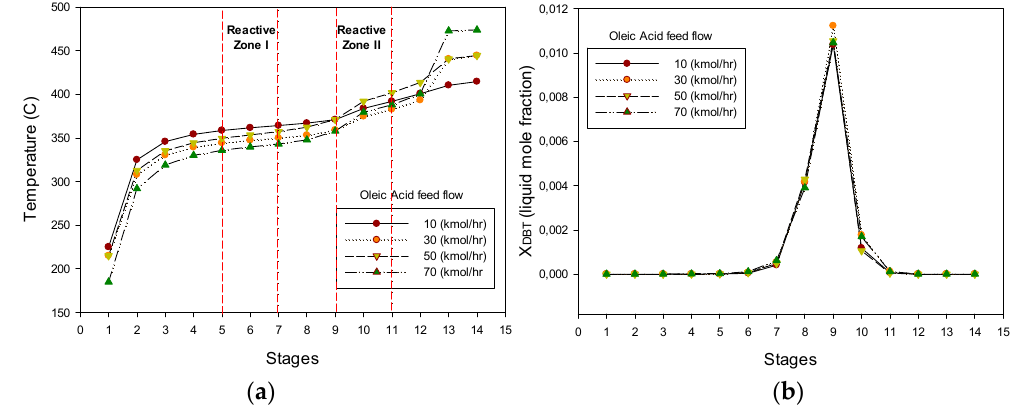
Figure 5. ( a ) Temperature profile along the RDC. ( b ) DBT liquid composition profile.